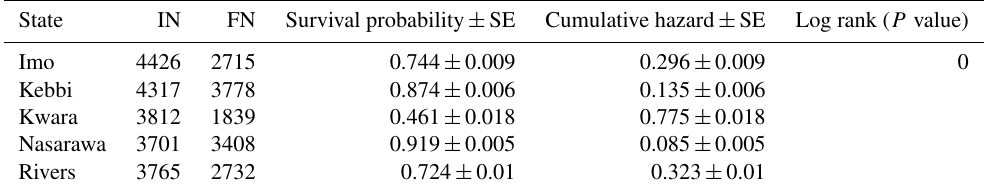
Table 11. Effect of agroecologies on survival performance of female birds raised on-farm in ACGG Nigeria project zones (22–70 weeks) (2016–2018).